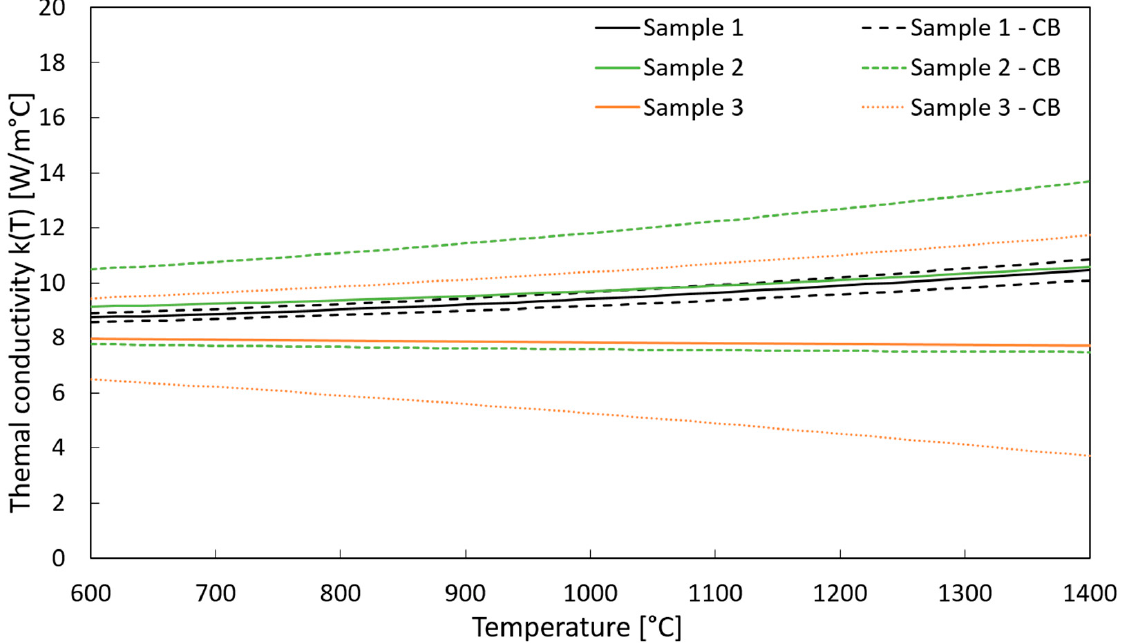
Figure 4. Estimated thermal conductivity for three different samples with the corresponding 95% confidence bounds (CBs).